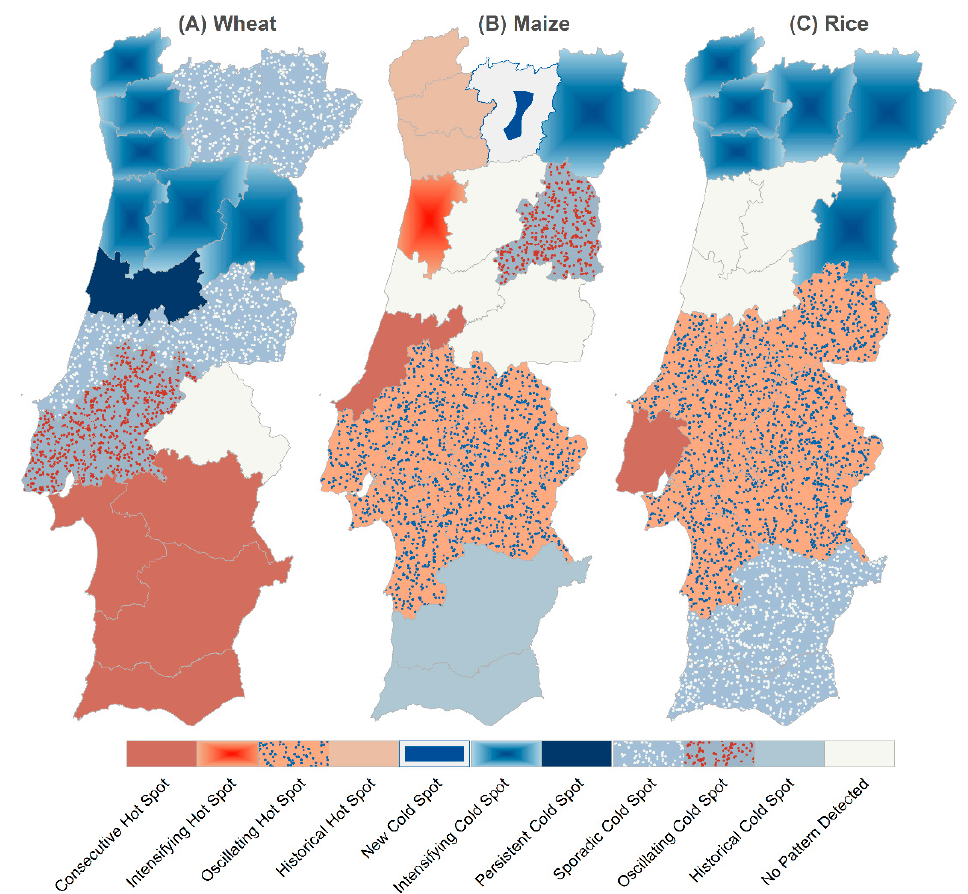
Figure 10. Wheat ( A ), maize ( B ), and rice ( C ) production trend